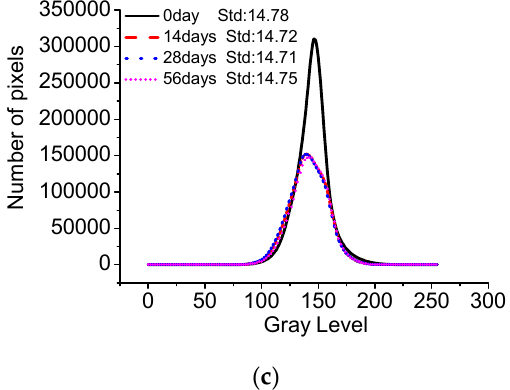
Figure 18. Gray of C40, C50, and C55 exposed to salt fog environment after different exposure times. ( a ) C40. ( b ) C50. ( c ) C55.